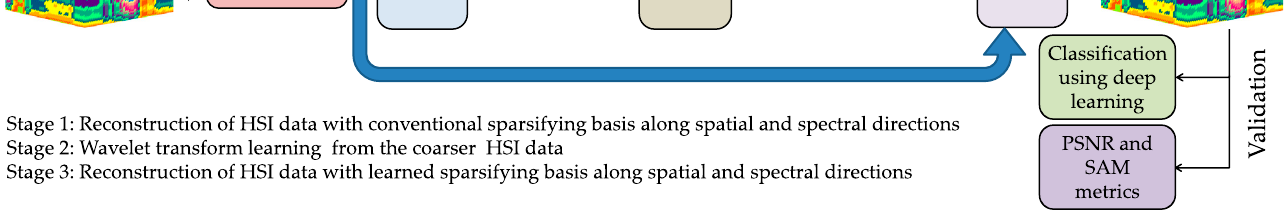
FIGURE1| Completework fl ow.Theproposedmethodconsistsofthreesteps:1)reconstructionofcoarserHSIdatawithconventionalsparsifying basis,2)learningof the sparsifying basis from this coarser HSI data, and 3) using the learned sparsifying basis to reconstruct the HSI data. Finally, the quality of reconstructed HSI data is evaluated via standard reconstruction metrics and via an